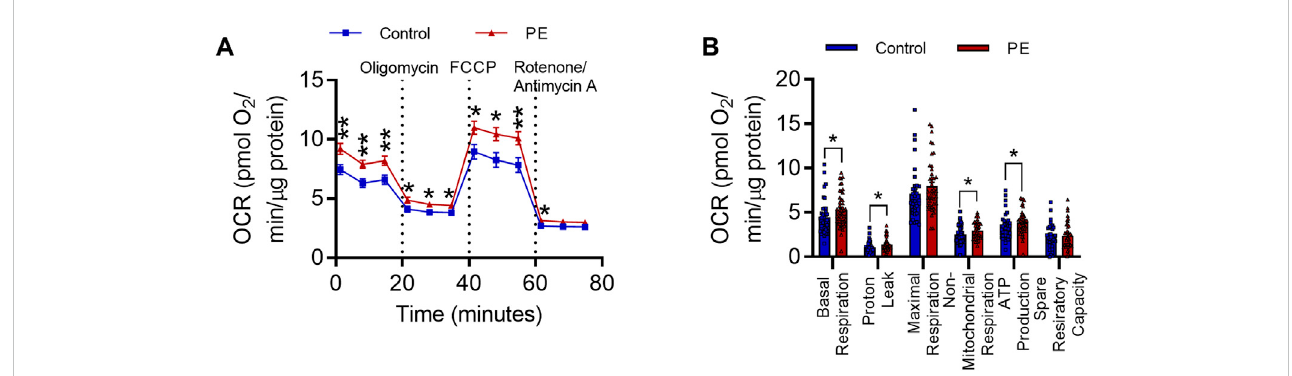
FIGURE 2 Pre-eclampsiaserumaltersmitochondrialfunctionindifferentiatedSH-SY5YCells. (A) Oxygenconsumptionrateduring80-minSeahorseXFMitoStress Test. Mean OCR values are normalized to protein content per well. (B) Graph representing individual parameters of respiration, calculated from the values plotted in I. Data are mean +SEM from N = 10 serum samples for each group with n = 1 – 5 wells per sample for I and J, or, expressed as percentage of the control. [* p < 0.05, ** p < 0.01 vs. control. Mixed effects model and post-hoc Fisher ’ s least signi fi cant difference (LSD) test for (A) , mann-whitney test for (B) ].